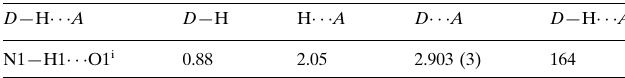
axis. Weak interactions between O atoms of the nitro groups